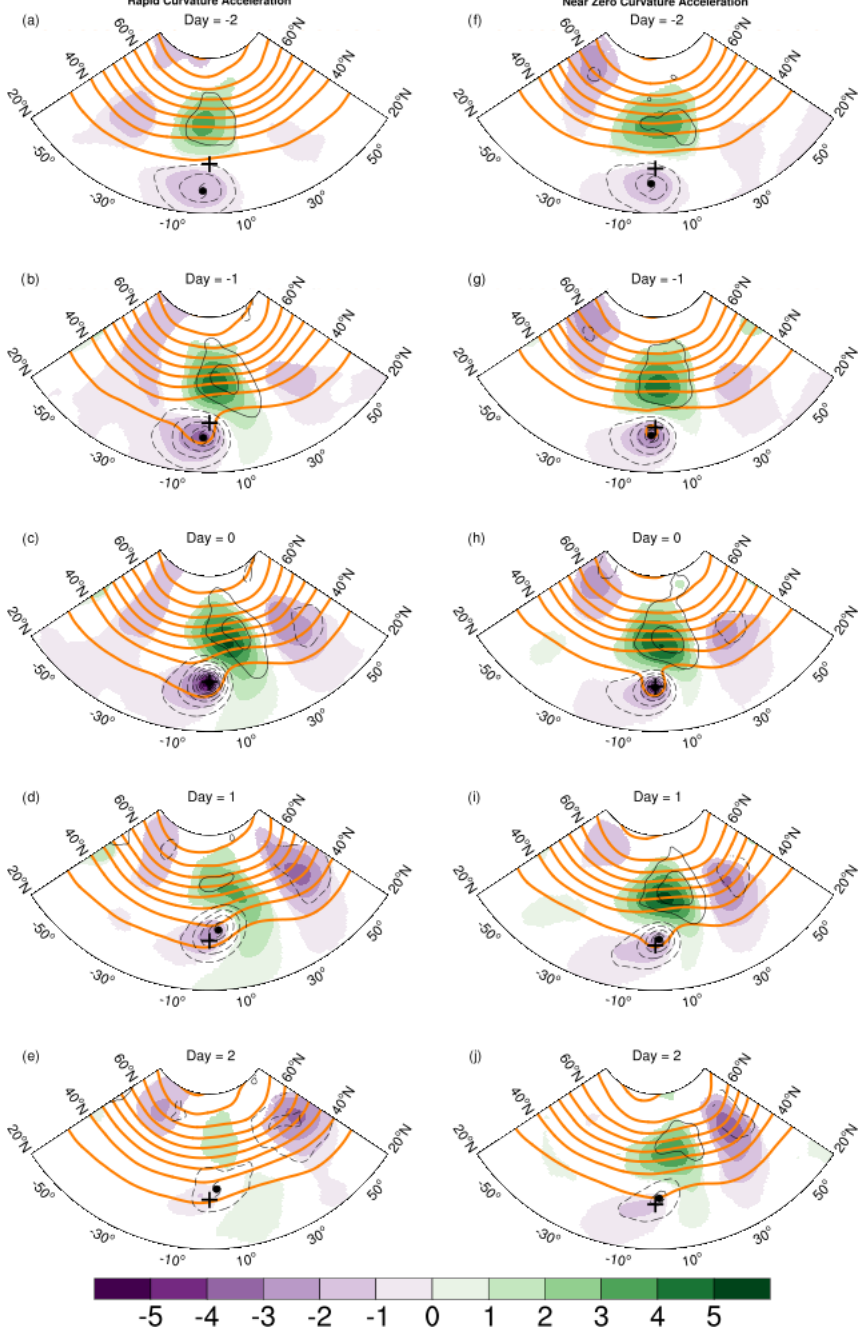
Figure 7. As in Fig. 4, except for rapid (a–e) and near-zero (f–j) curvature